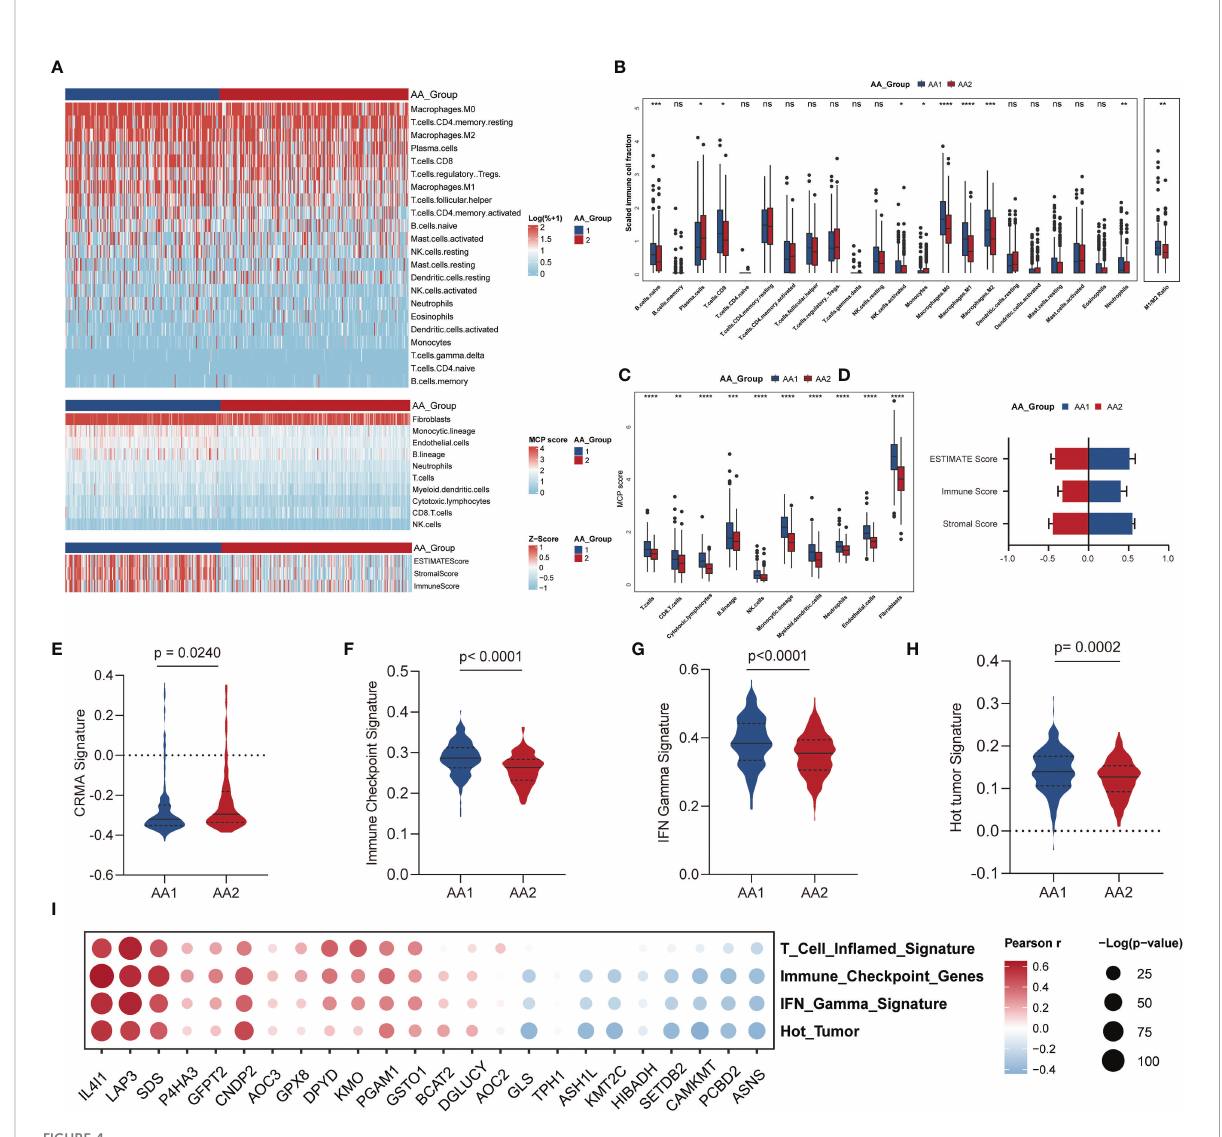
FIGURE 4 Correlation of the AA subtypes with immune in fi ltration. (A) Heatmap of the abundance of tumor microenvironment cell fractions using CIBERSORT, MCP-counter, and ESTIMATE algorithm between two subtypes. (B) Boxplot of the abundance of immune cell populations distinguished by two subtypes analyzed by the CIBERSORT algorithm. (Mann-Whitney Wilcoxon test) (C) Boxplot of the abundance of immune cell populations, fi broblasts, and endothelial cells distinguished by two subtypes analyzed by MCP-counter algorithm. (Mann-Whitney Wilcoxon test) (D) Boxplot of ESTIMATE score, immune score, and stromal score in two subtypes analyzed by ESTIMATE algorithm. (Mann-Whitney Wilcoxon test) (E – H) Tumor immune-related signatures in two subtypes. (Mann-Whitney Wilcoxon test) (I) Bubble chart of the correlation